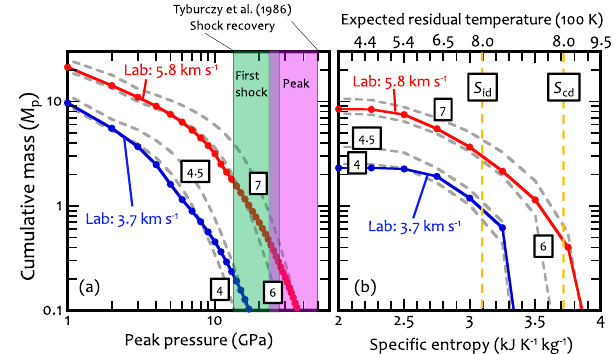
Fig. 4 Pressure and entropy (post-shock residual temperature) experienced during impacts. a The cumulative mass at a given peak pressure as a function of the peak pressure. The blue and red points correspond to the results of the Lab – simulation at low and high v imp , respectively. The four dashed grey lines are the results of the Ryugu – simulation. The numbers in the black boxes on the lines are the impact velocities used in the Ryugu – simulation. The green and pink shaded regions indicate the range of pressures in a previous impact experiment 17 . b The same as ( a ), except the cumulative mass at a given entropy is shown as a function of entropy. The vertical dashed yellow lines indicates the entropies required for incipient and complete devolatilisation of the target (Supplementary Note S8). The expected residual temperature T res is also shown on the top x -axis. The calculated results shown in Fig. 4a and b can be found in Supplementary Data 2 and 3,